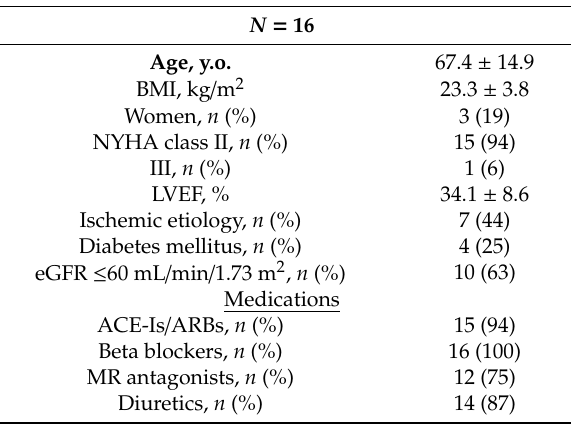
Table 1. Baseline characteristics.